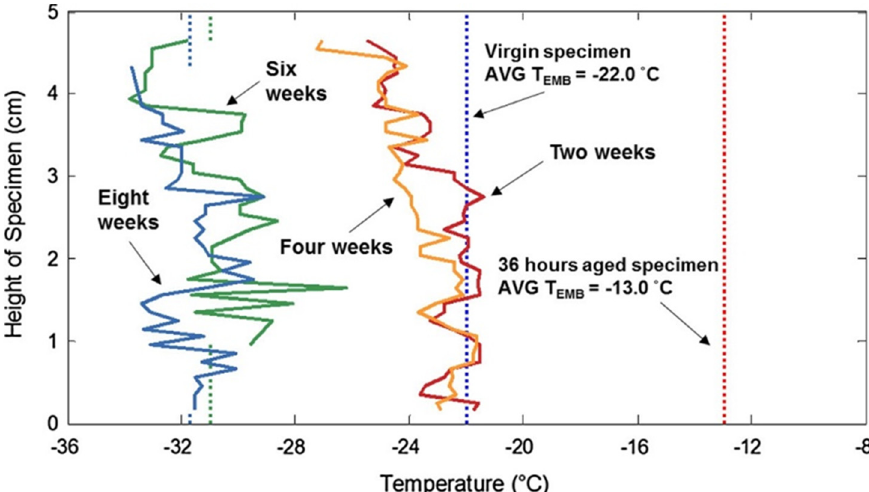
Figure 16. Average measured embrittlement temperatures of rejuvenator-treated oven-aged asphalt concrete samples (for 36 h at 135 °C) after dwell times of 2, 4, 6, and 8 weeks. For comparison, the embrittlement temperatures of the short-term aged (i.e., virgin) samples and of oven-aged samples for 36 h at 135 °C of − 22.0 °C and − 13 °C, respectively, are also noted (see dotted and dashed lines respectively). Note that after two weeks of dwell time, the unaged mixture embrittlement temperature was already restored. Also, at 2 and 4 weeks of dwell time, the top material layers have a cooler embrittlement temperature, because the rejuvenator had more time to act upon the binder.